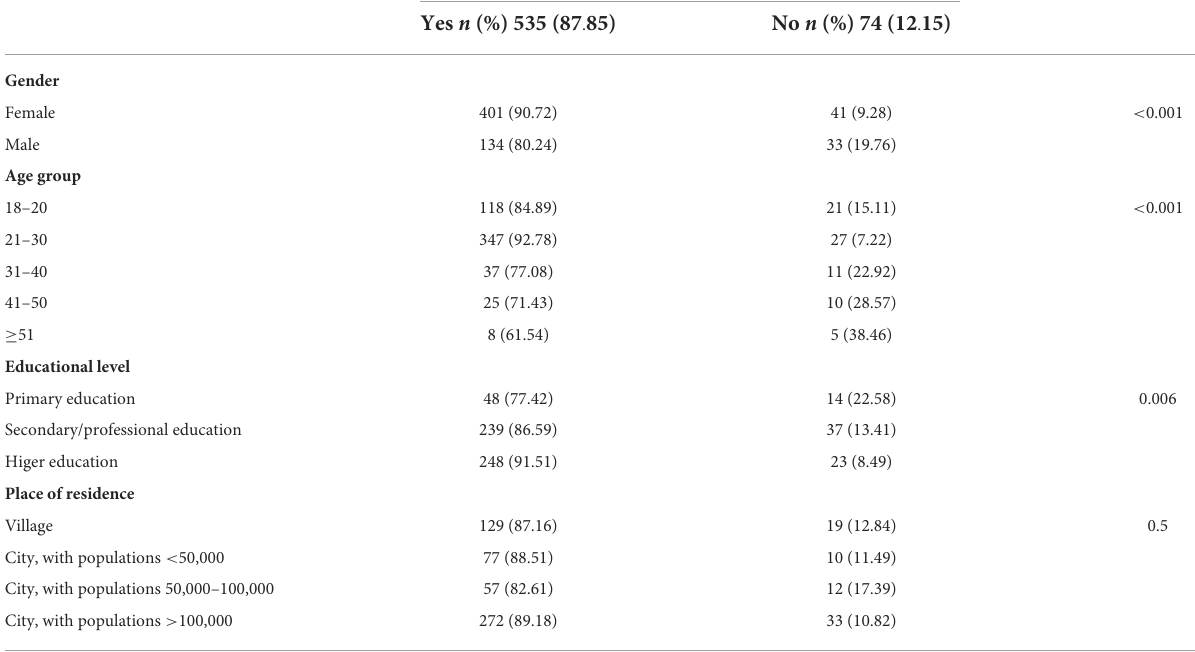
TABLE 2 Declaration of purchase of preserved food by sociodemographic